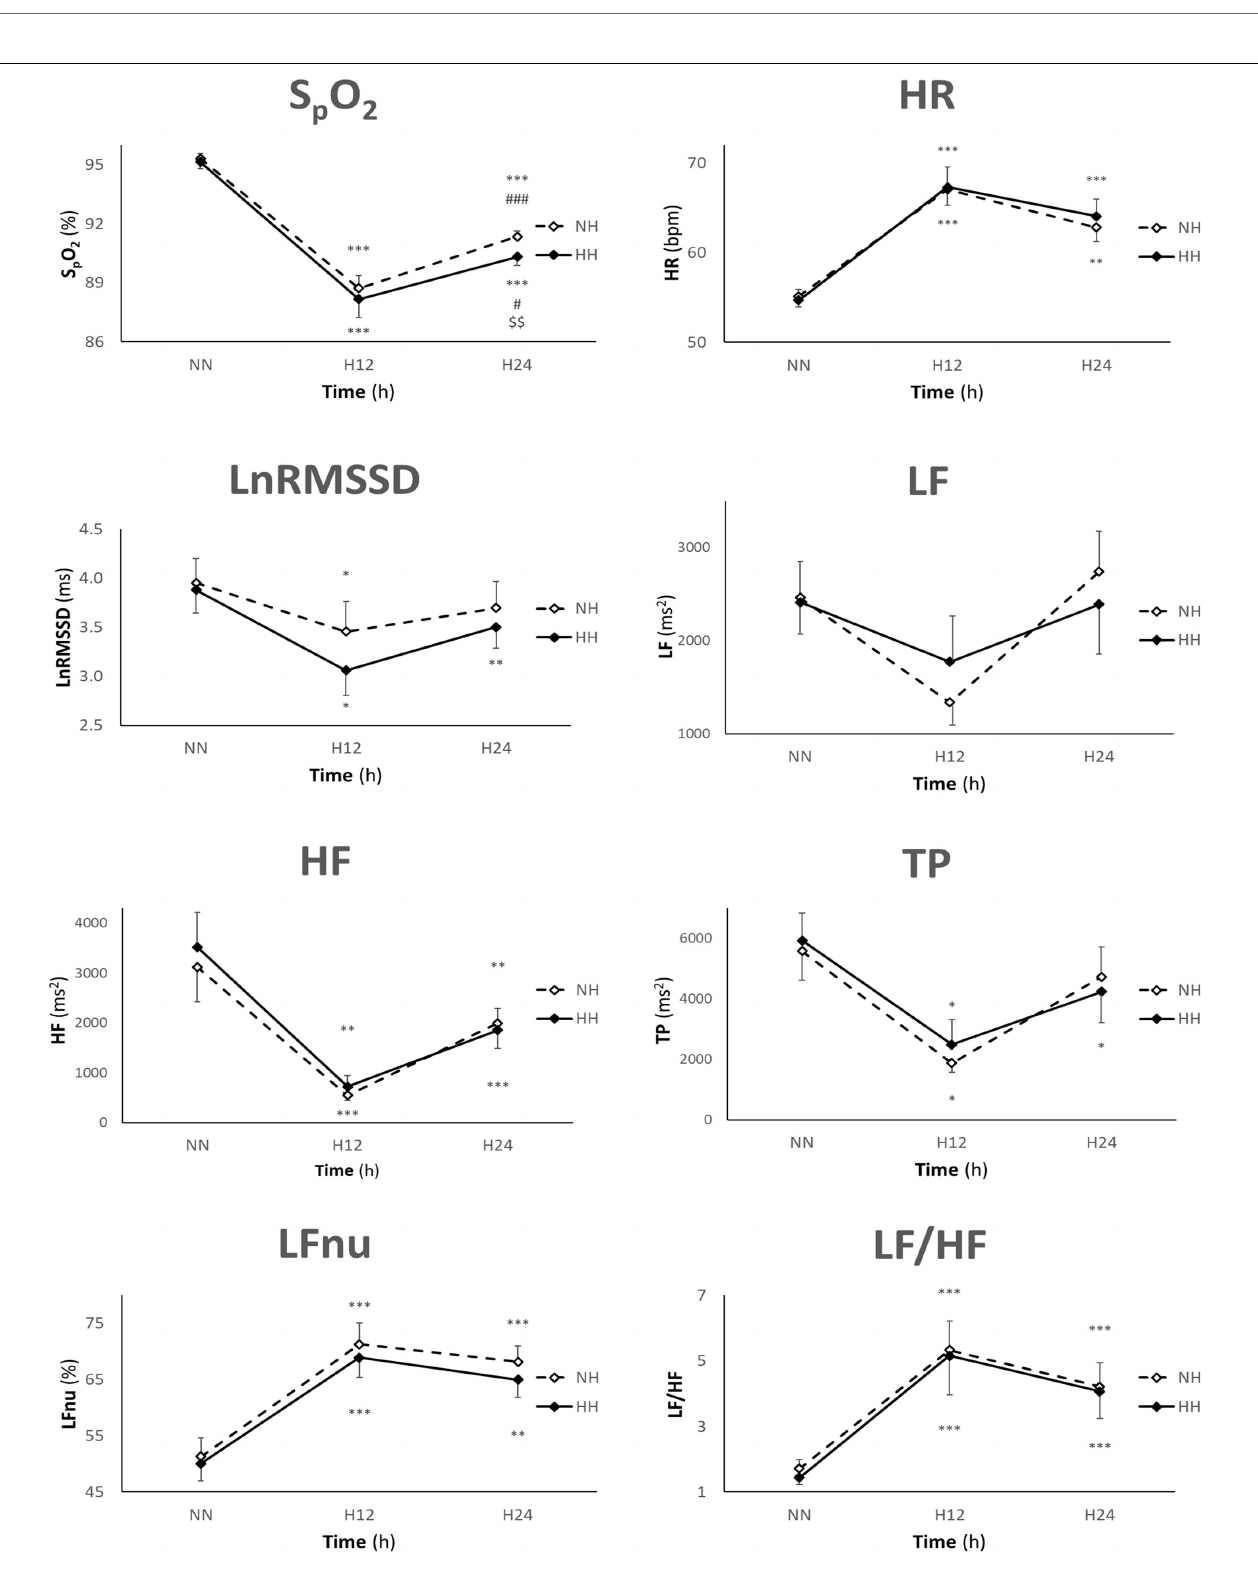
FIGURE 1 | Values are presented as mean ± SE. n = 41, 25, and 41 for NN, H12, and H24, respectively ( n = 36, 18, and 37 for S p O 2 ). HR, heart rate; LnRMSSD, natural logarithm of the root mean square of the successive differences; LF, low frequency; HF, high frequency; TP, total power; NN, normobaric normoxia; NH, normobaric hypoxia; HH, hypobaric hypoxia; bpm, beat per minute; h, hours; ∗ p < 0.05, ∗∗ p < 0.01, and ∗∗∗ p < 0.001 for difference with NN, # p < 0.05, ### p < 0.001 for difference with H12, $$ p < 0.01 for difference with NH.